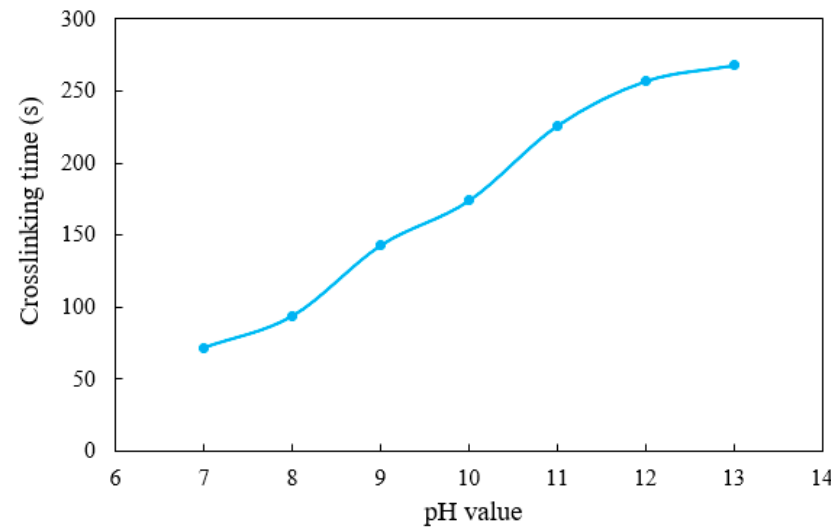
Figure 8. Curve of crosslinking time versus pH value.